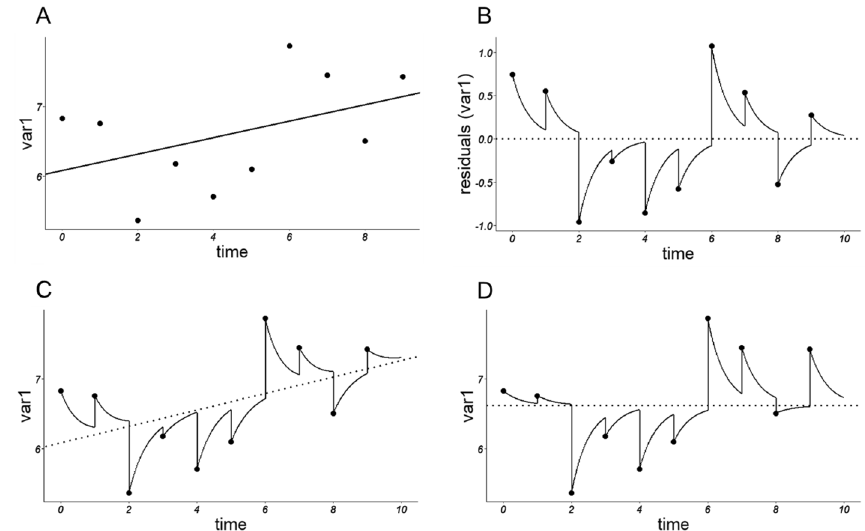
Fig. 3 Combination of trend ( A ) and dynamics ( B ) in the CT-LCM-SR ( C ) in comparison to a CT-AR(1) model ( D ). Same simulated data as used in Fig. 1. Panel A CT-LCM-SR-implied trend. Panel B continuous-time dynamic process of the residuals. Panel C Putting trend and dynamic process together. Panel D A standard CT-AR(1) model, which ignores any trend in the data. Black solid lines visualize model implied expected trajectories (given past observations). The model implied predictions of the CT-LCM-SR (Panel C ) are a combination of the static trend component (Panel A ) and the autoregressive structure of the residuals over time as reflected by the CT auto-effect (Panel B ). The dynamic part gives information on how much of the deviation from the trend on time T is expected to be carried over to future states with growing time intervals. A mean-reverting process is shown, which means that the CT auto effect is negative (corresponding to DT autoregressive effects between 0 and 1 for every time